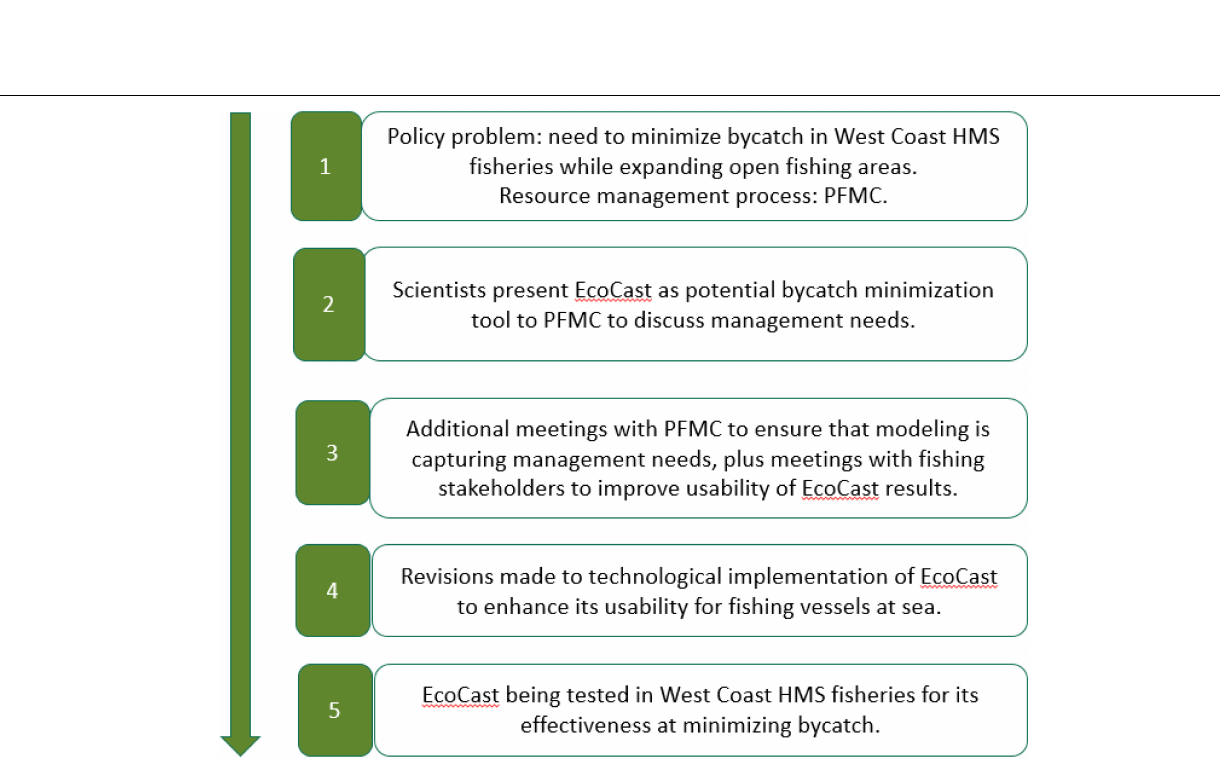
FIGURE 7 | California Current Dynamic Ocean Management Case Study